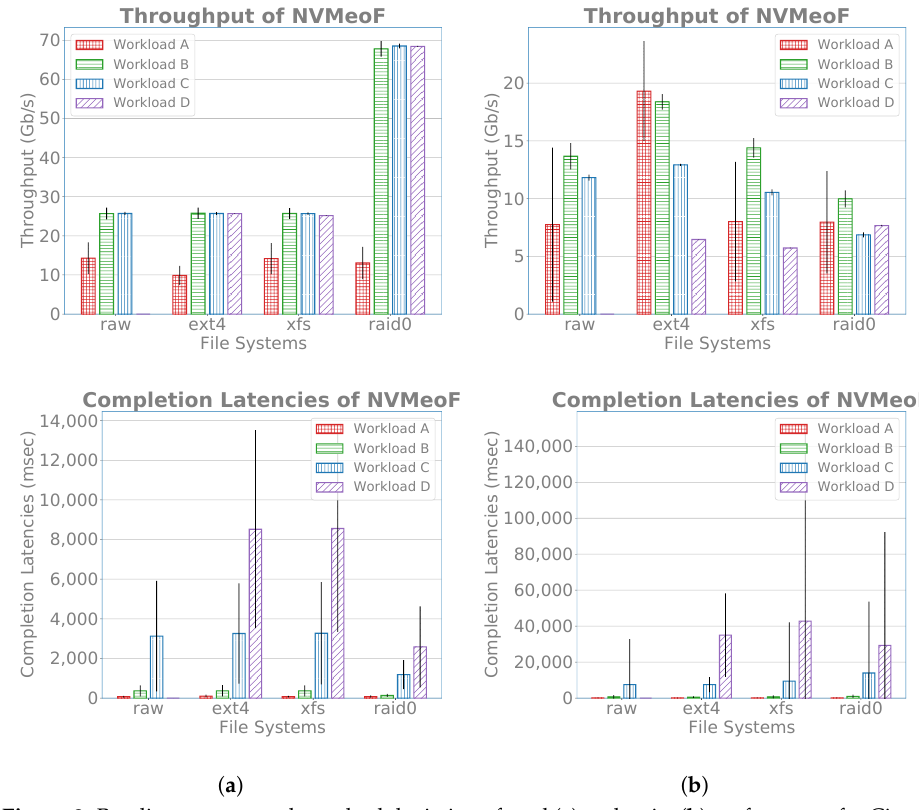
Figure 3. Baseline average and standard deviation of read ( a ) and write ( b ) performance for Ciena DTN. Compared to Ext4, XFS shows significantly low remote write performance with Ciena DTN. This indicates that XFS may not suit applications that write few files